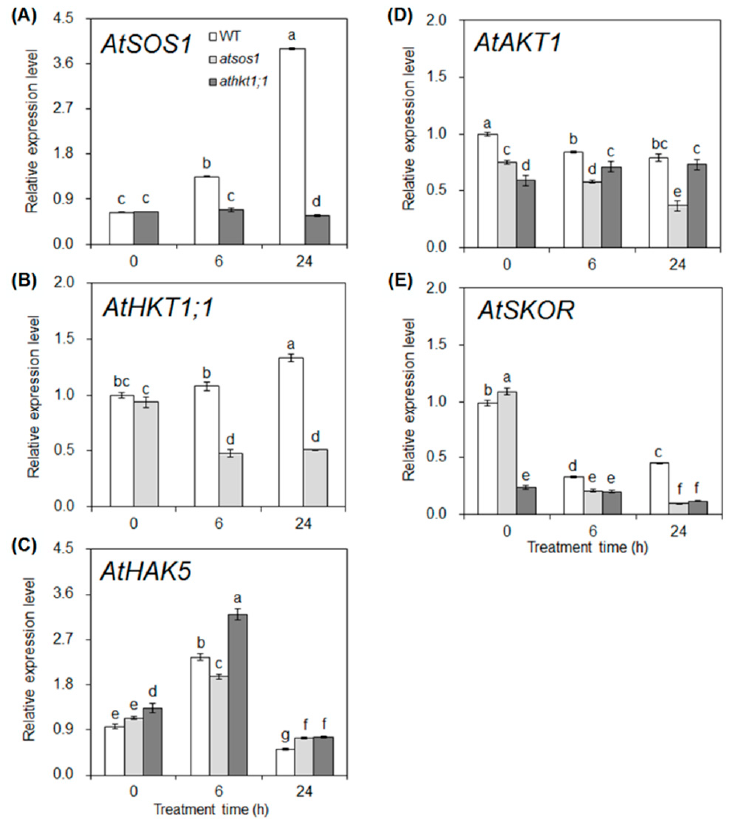
Figure 3. Na + and K + transporter gene expression in WT, atsos1 , and athkt1;1 roots exposed to 25 mM NaCl at different times. Quantitative RT-PCR analysis of AtSOS1 ( A ), AtHKT1;1 ( B ), AtHAK5 ( C ), AtAKT1 ( D ), and AtSKOR ( E ) mRNA in roots of 6-week-old WT, atsos1 , and athkt1;1 that were treated with 25 mM NaCl for 0, 6, and 24 h. ACTIN was used as an internal control. Values are means ± SE ( n = 9), and bars indicate SE. Columns with different letters indicate significant differences at p < 0.05 (Duncan’s test).